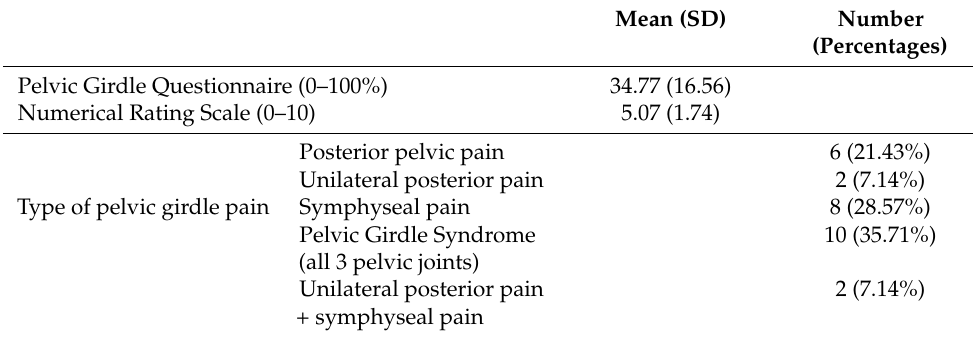
Table 2. Characteristics of cases with pelvic girdle pain (n = 28).